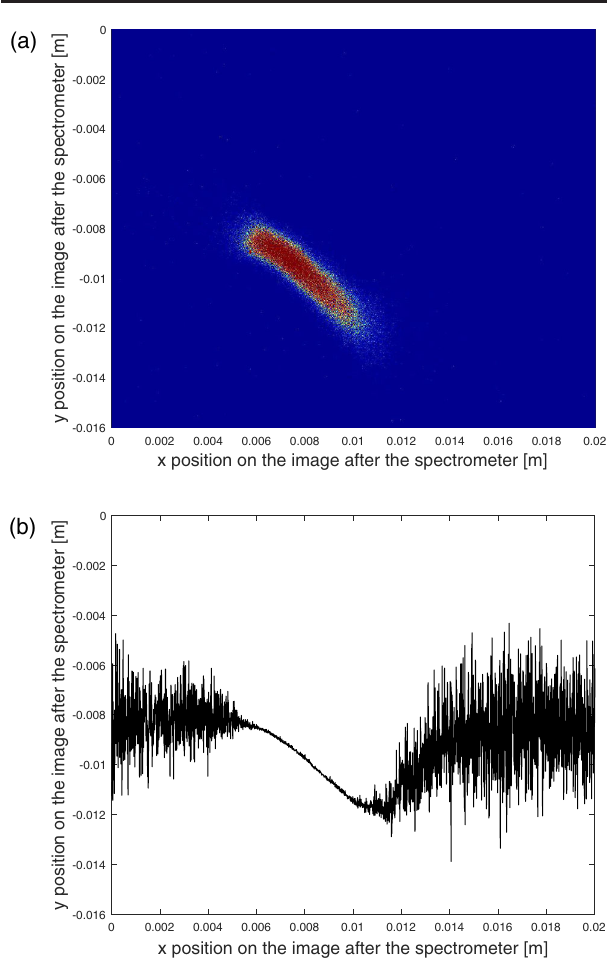
FIG. 7. (a) Screen-6 image taken with dechirper offset of 2 mm and spectrometer magnet on, and (b) the projected image of the corresponding pencil beam. The bunch head is at the upper-left corner of the screen-6 image.